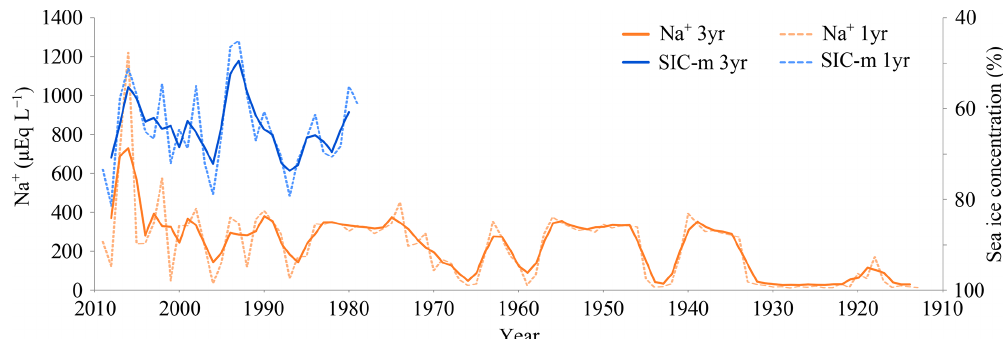
Figure 10. Time series of mean SIC-m (blue, right y axis) and Na + (orange, left y axis) over the period from 1913 to 2009. Note that the right y axis is reversed to highlight the high degree of